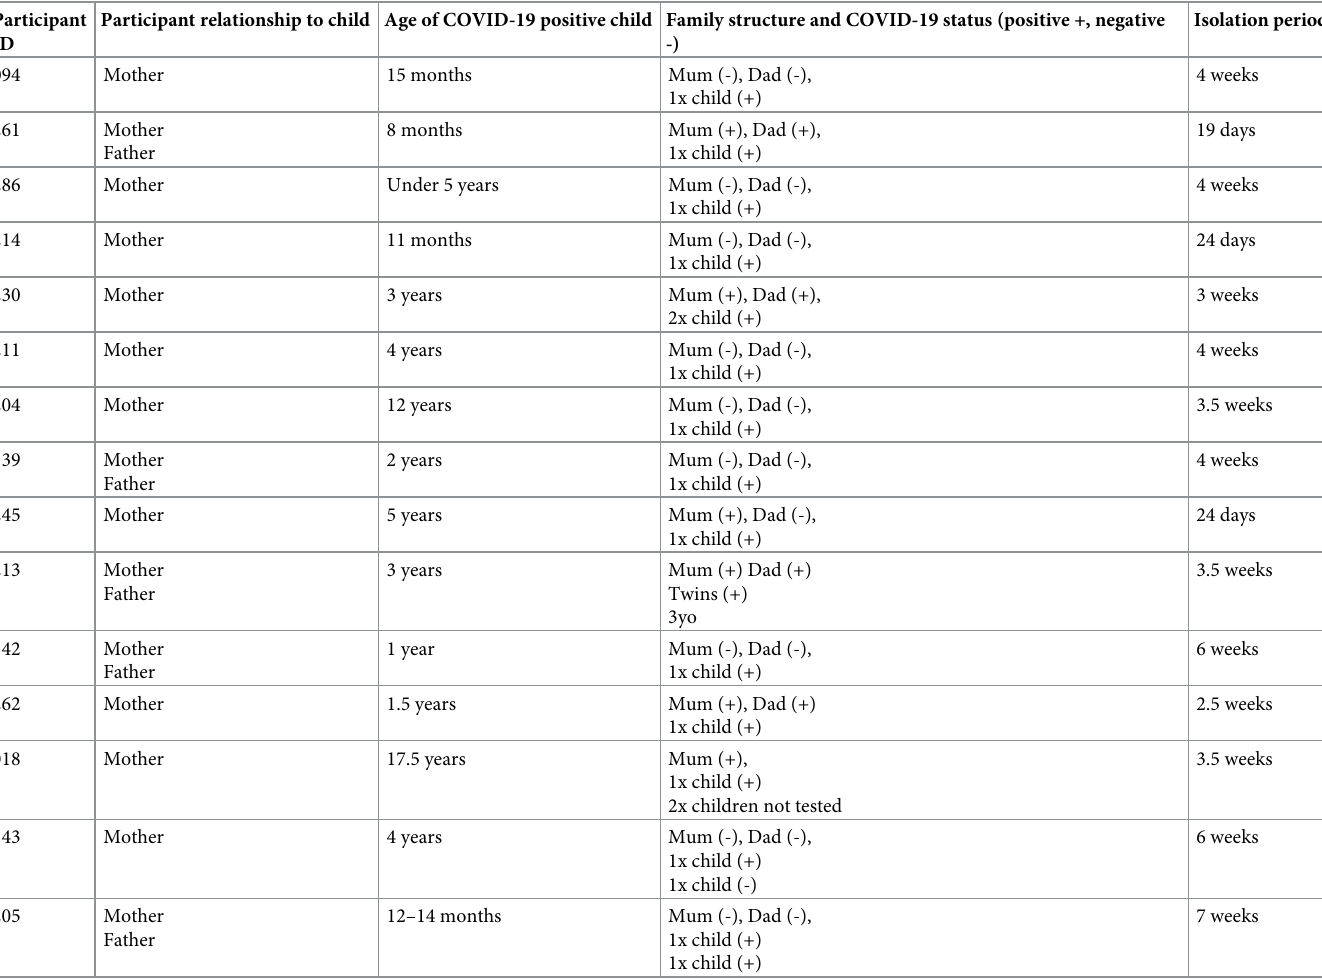
Table 1. Demographic details of participating families.